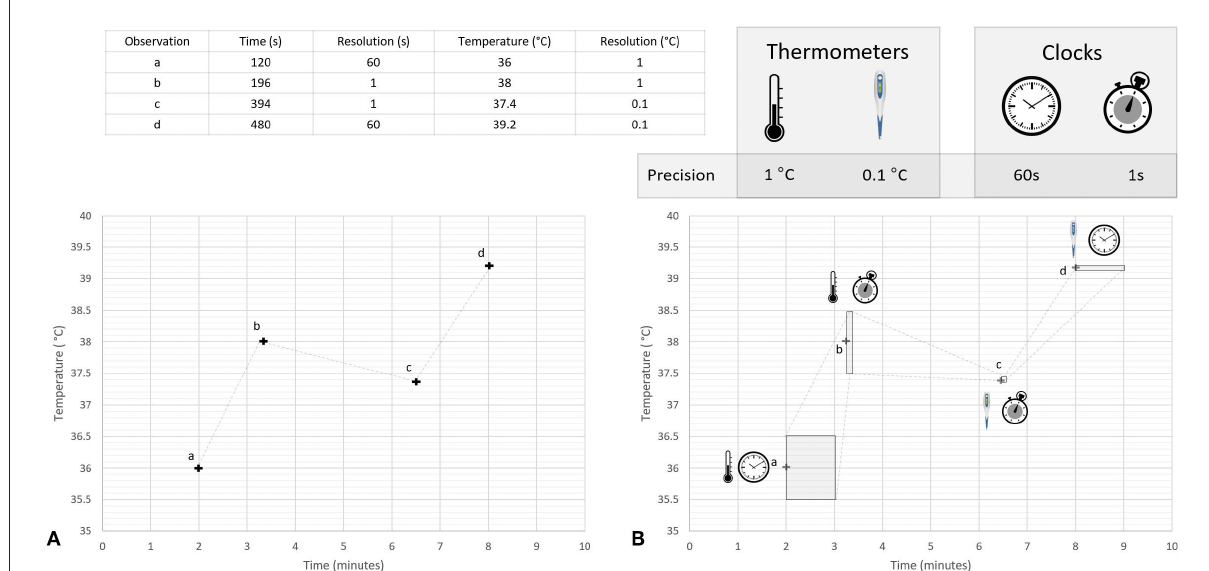
FIGURE3 Conceptual illustration of heteroscedastic uncertainties associated with a time series of temperature measurements. This figure illustrates concepts discussed in the literature cited in Sections 4.3, 7.1, and 7.2. Two different thermometers were used to measure temperatures during a hypothetical experiment, a mercury thermometer with a resolution of 1 ◦ C and a digital thermometer with a resolution of 0.1 ◦ C; times for each temperature were recorded using two different timepieces, a wall clock with a temporal resolution of 1 min and a wristwatch with temporal resolution of 1 s. Four observations (labeled a, b, c, and d) are made using different combinations of these clocks and thermometers. Panel (A) shows a plot of the numerical values displayed on the instruments when making the observation, while Panel (B) uses shaded regions to represent the range of possible true values that could have resulted in these values. The shape of the shaded regions in Panel (B) are determined by the temporal and thermal resolution of the instruments used to make each individual observation. For simplicity, other sources of uncertainty are not considered in this